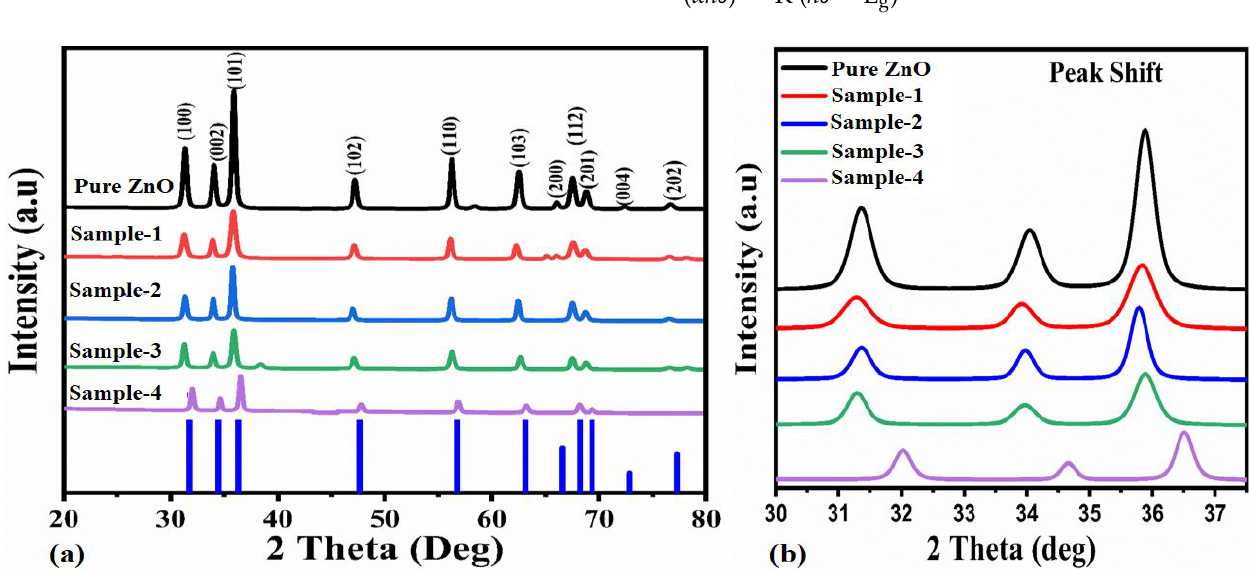
Figure 1. ( a ) Powder XRD patterns of pure ZnO and green synthesized ZnO samples prepared with various amounts of leafy extract of S. oleracea (10 mL, 20 mL, 30 mL, and 40 mL) ( b ) illustrates the shift in (100), (002) and (101) Bragg reflections of as-synthesized samples. Table 1. Calculated average crystallite size (nm) for pure ZnO and green synthesized ZnO samples prepared in the presence of various amounts of leaf extract of S. oleracea .